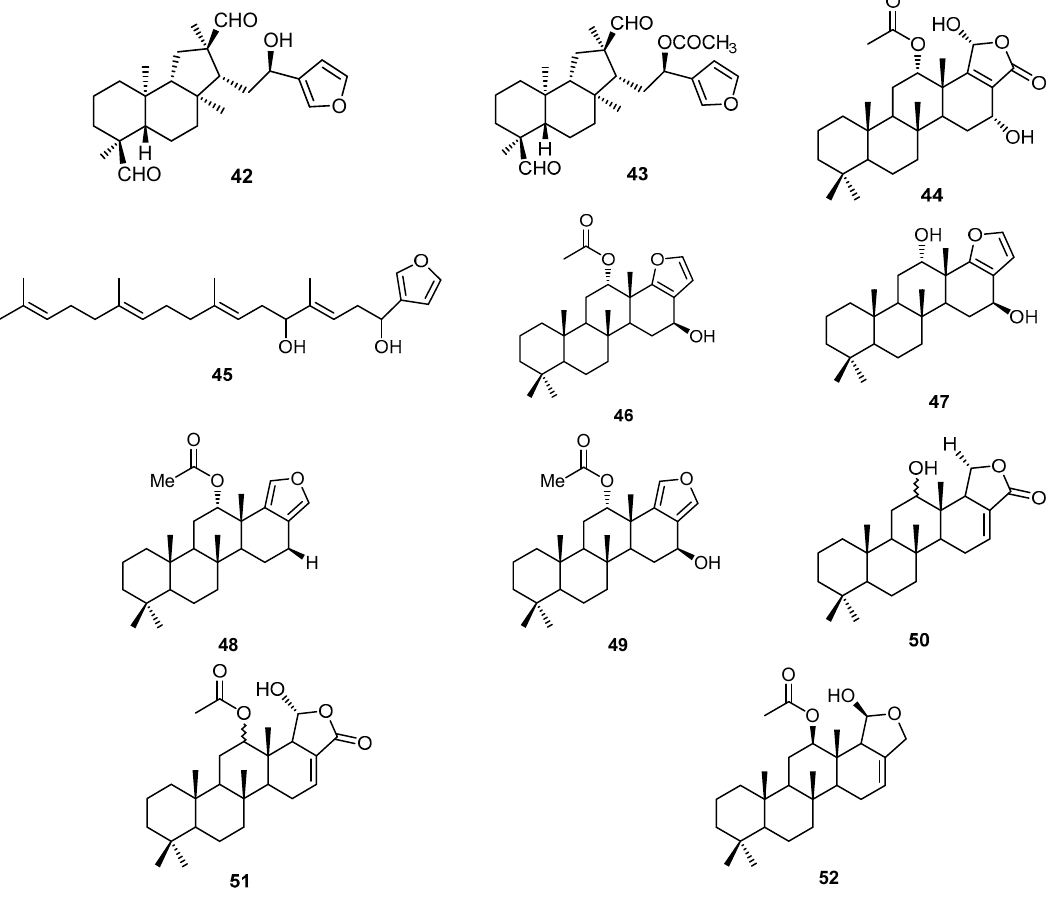
Figure 12. Chemical structures of 20-formylhyrtiosal ( 42 ), 16- O -acetyl-20-formylhyrtiosal ( 43 ), 12- α - O -acetylhyrtiolide ( 44 ), 5,10-dihydroxyfurospinulosine-1 ( 45 ) and compounds 46 – 52 .